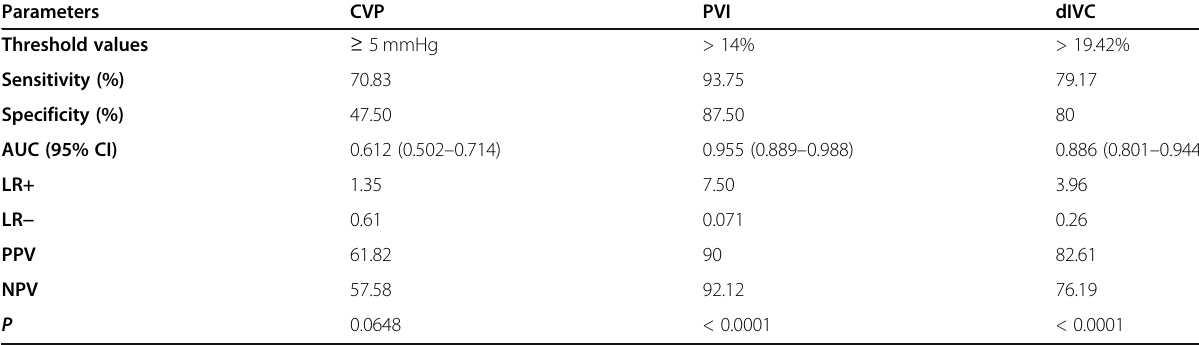
Table 3 The comparison of performances between parameters Parameters